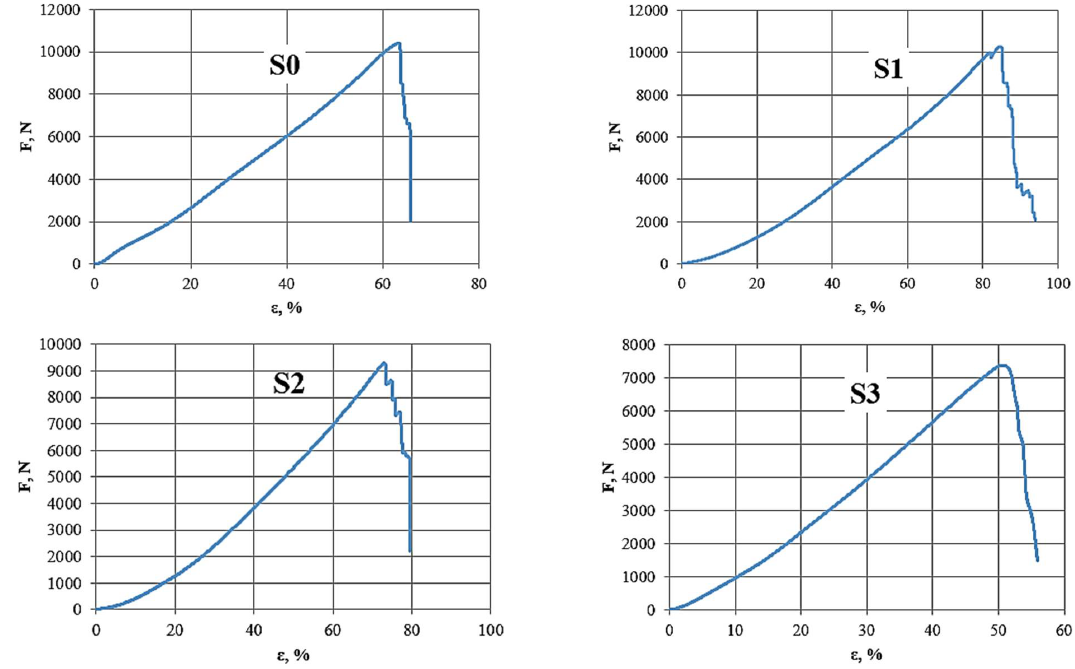
Figure 7. F ( ε ) diagrams of sample TS501_50 samples subjected to a static tensile test; Source: Own research (2021).